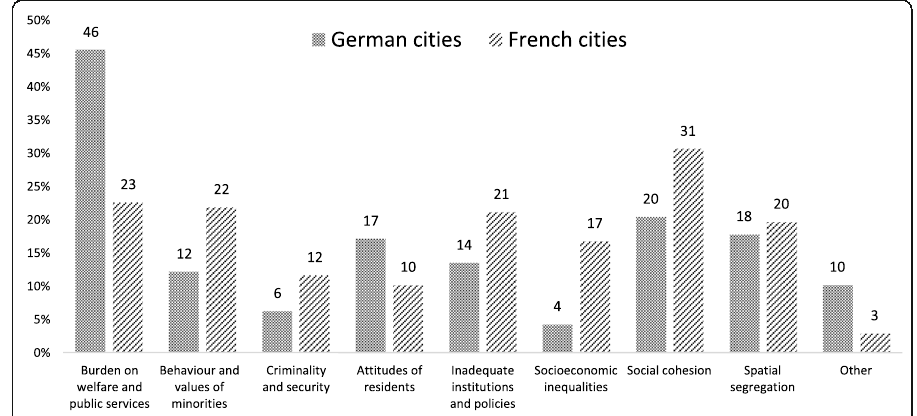
Fig. 2 Perceived burdens of diversity for the cities. Source: CityDiv Survey, N (German cities)=303, N (French